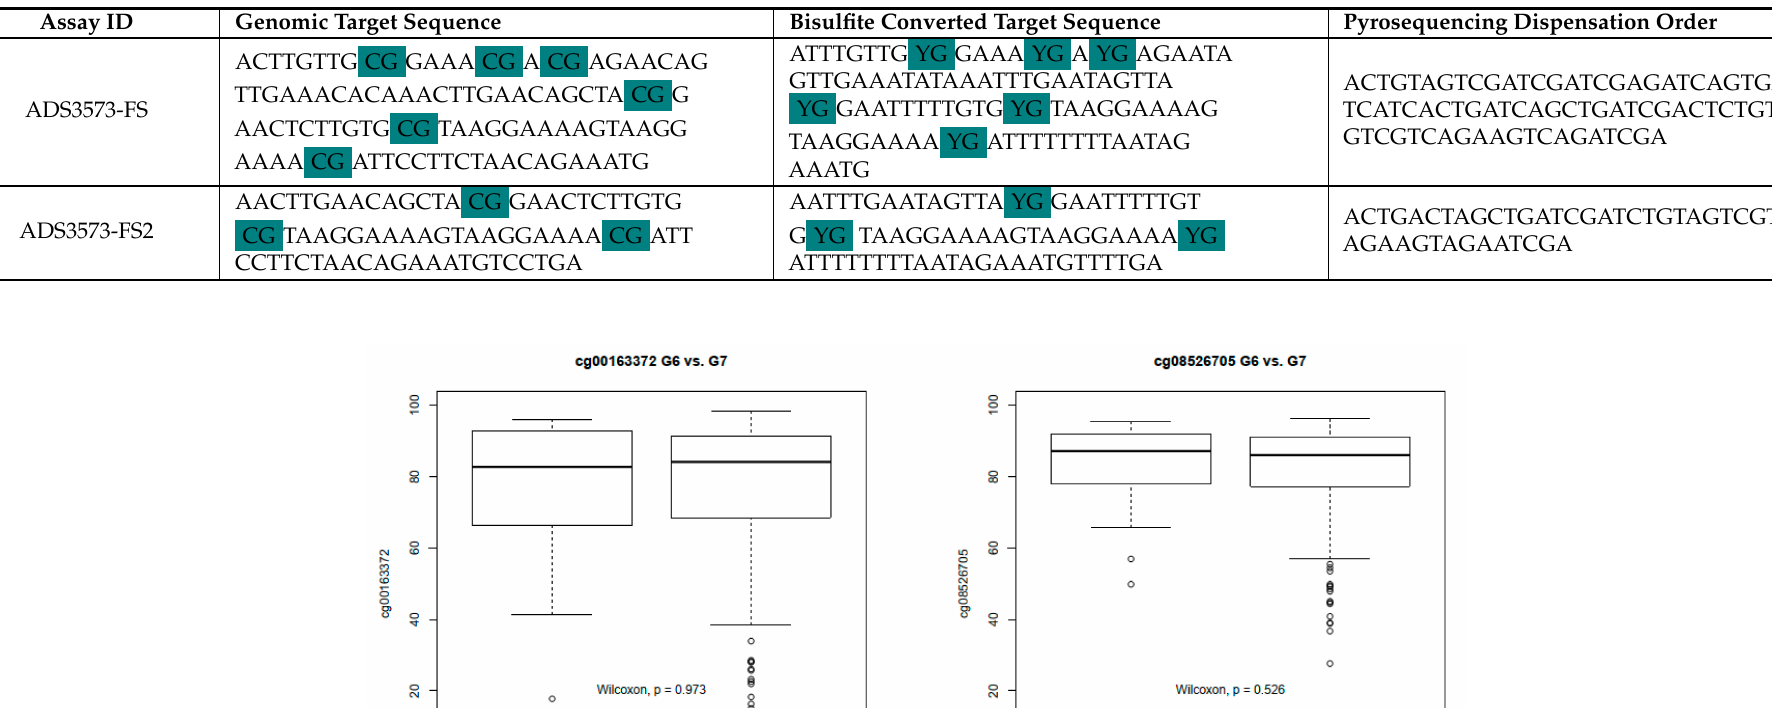
Table A1. MYC Pyrosequencing Assay Target Sequences; green highlight denotes the CpG sites covered in the present study.